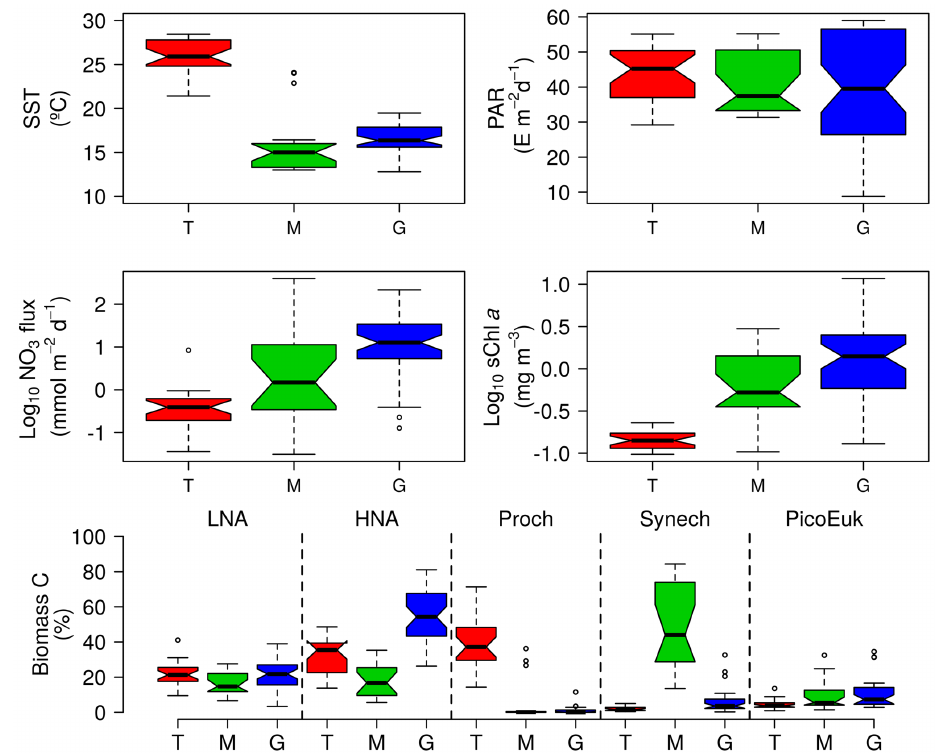
Figure 2. Box-and-whisker plots of sea surface temperature (SST), surface photosynthetic active radiation (PAR), nitrate supply (NO 3 Flux), surface chlorophyll a concentration (sChl a ), and contribution to total picoplankton biomass of low (LNA) and high (HNA) nucleic acid content bacteria, Prochlorococcus (Proch), Synechococcus (Synech), and small picoeukaryotes (PicoEuk) computed for the tropical and subtropical Atlantic Ocean (T), the Mediterranean (M), and the Galician coastal upwelling (G). In each box, the central mark indicates the median, the notches the 95% confidence interval for the median, and the bottom and top edges of the box the 25th and 75th percentiles, respectively. The whiskers extend to the most extreme data points not considered outliers, and the outliers are plotted individually using white